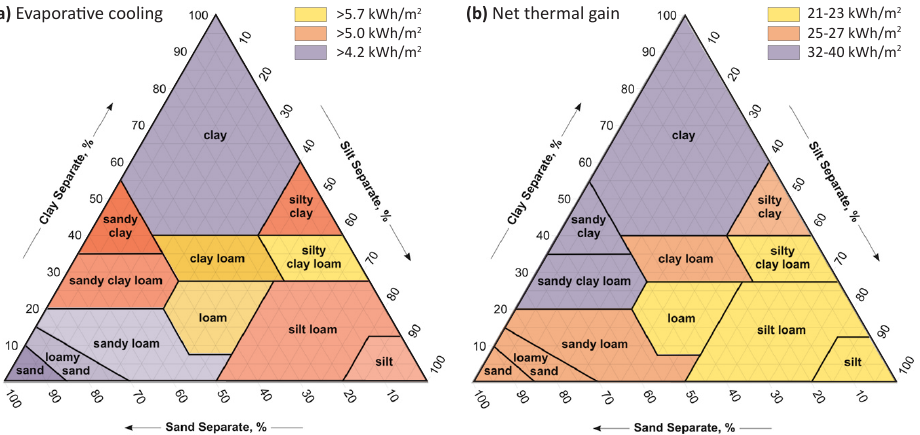
Figure 6. Effects of soil texture on intrinsic evaporative cooling as measured by ( a ) evaporative heat losses and ( b ) net thermal gains by Mexican green roof soils, illustrating the greater evaporative activity of soils with fairly even distributions of particle sizes, as well as the potential for moisture-enhanced thermal conductivity—particularly in higher-clay soils—to counteract some of that benefit through greater sensible gains. Data show cumulative monthly values over the warmest summer month (15 July–15 August) in the semi-arid steppe climate of Laredo, TX, USA (Köppen BSh , Figure 8). Ambient humidity was the only source of